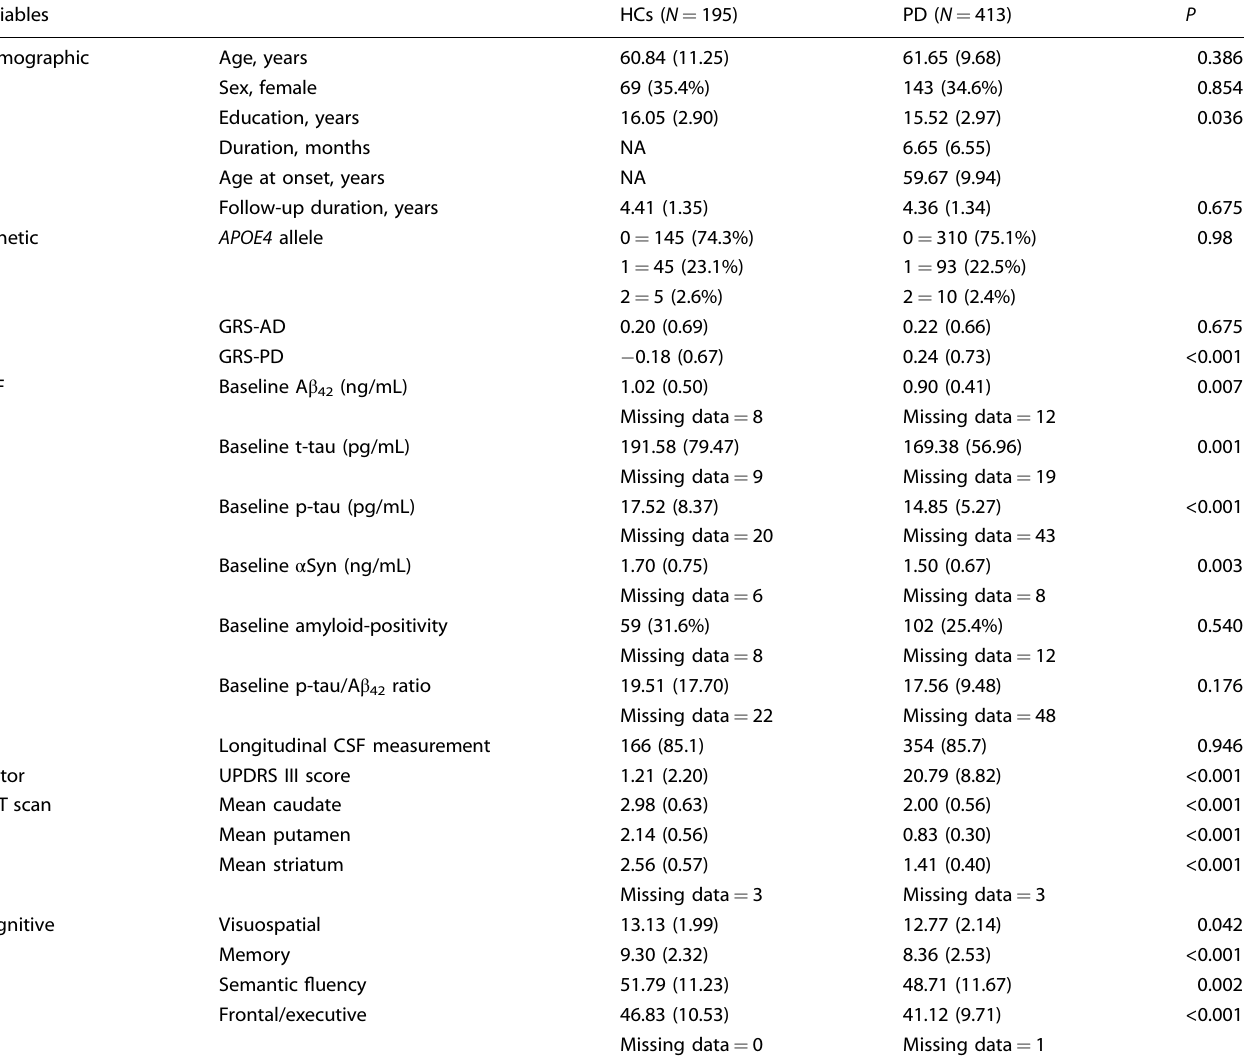
Table 1. Baseline demographics and clinical characteristics of the participants.